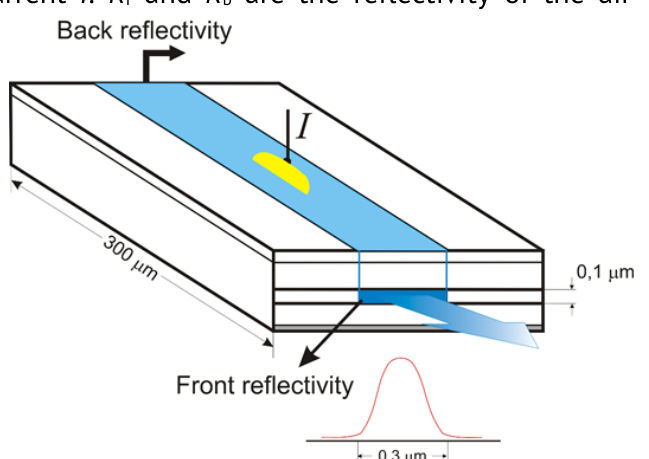
Figure 1. Setup of InGaAsP Fabry-Perot